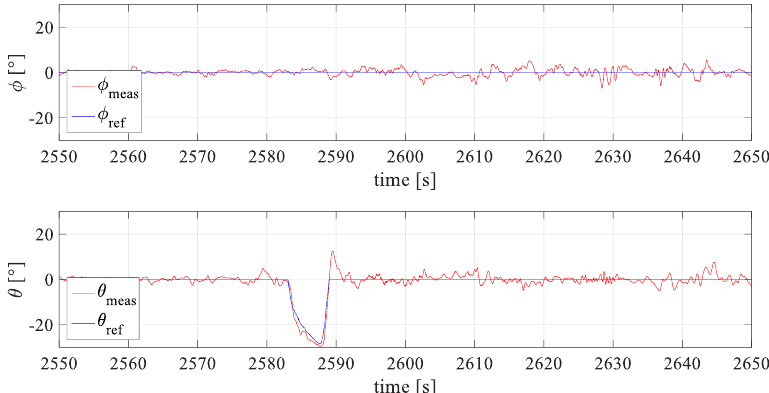
Figure 10. System response of PTX6 functionality testing.